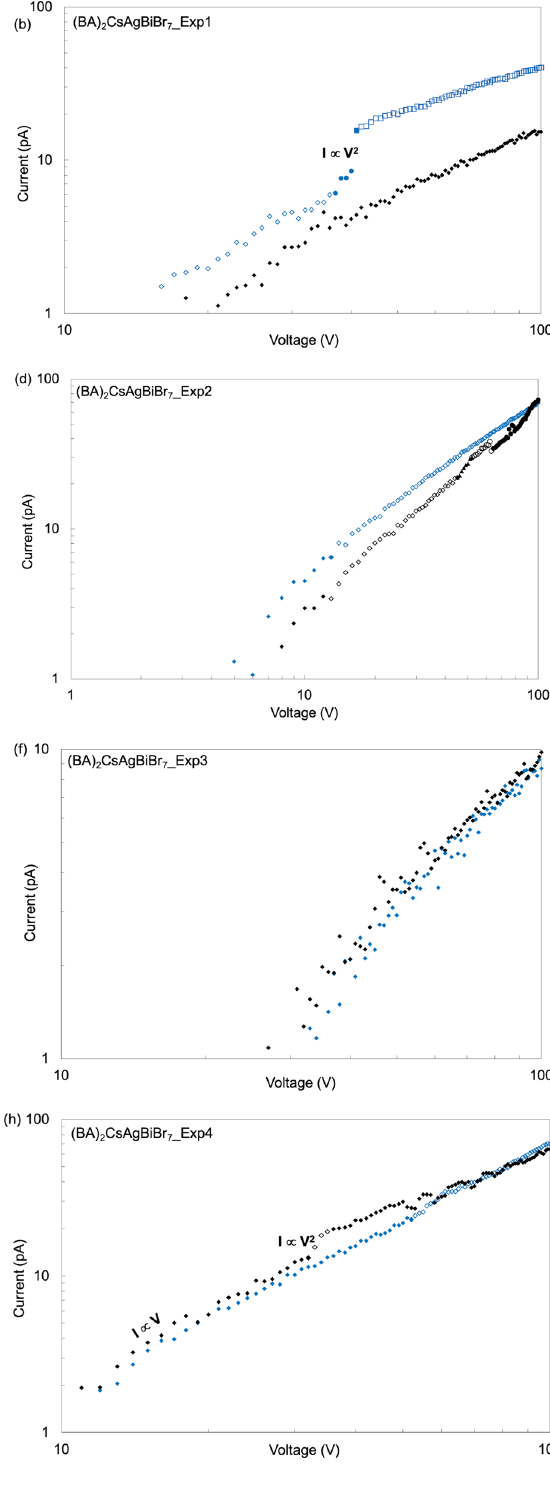
Figure 4. IV curves generated in the dark for the Ag- ( BA ) CsAgBiBr contacts. The IV curves in the forward and reverse scan directions for Ag-Exp1 lack complete symmetry ( a ); an SCLC regime identified in the forward scan direction ( b ). No clear regimes can be identified for Ag-Exp2 ( c , d ) and Ag-Exp3 ( e , f ); a very narrow SCLC regime can be identified in the reverse scan for Ag-Exp4 ( g , h ).